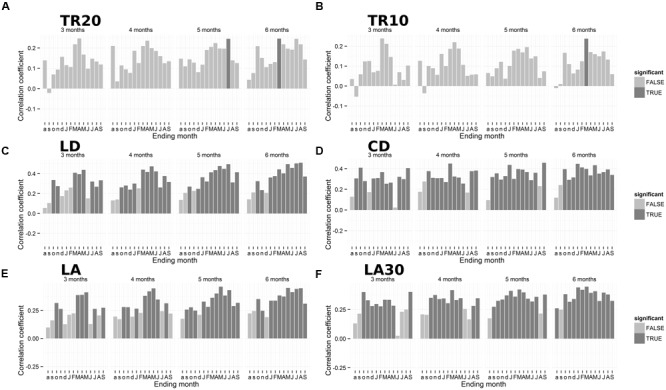
Plot of seasonal correlations between annual tree-ring parameters and total precipitation for 3, 4, 5, and 6-month seasons. (A) Ring-width (20 cores); (B) ring-width (10 cores); (C) lumen radial diameter; (D) cell radial diameter; (E) lumen area (LA); (F) LA of the 30% largest cells. Dark gray bars represent significant coefficients using a 95% confidence interval. Lowercase letters, previous year months; uppercase letters, current year months. Note the different scales of the y-axes. For acronyms see Table 1.